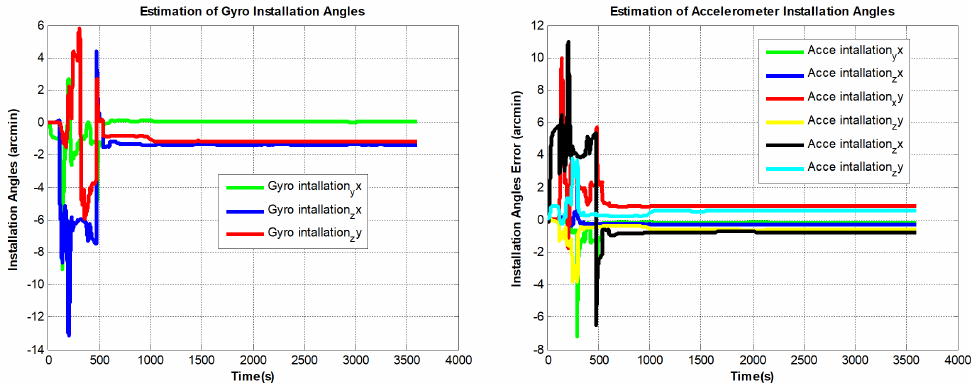
Figure 9. PIGA-based IMU installation angles estimation curves. Particularly, we draw the angular velocity sensitivity curve of PIGA separately in Figure 10 to perform a separate analysis of its